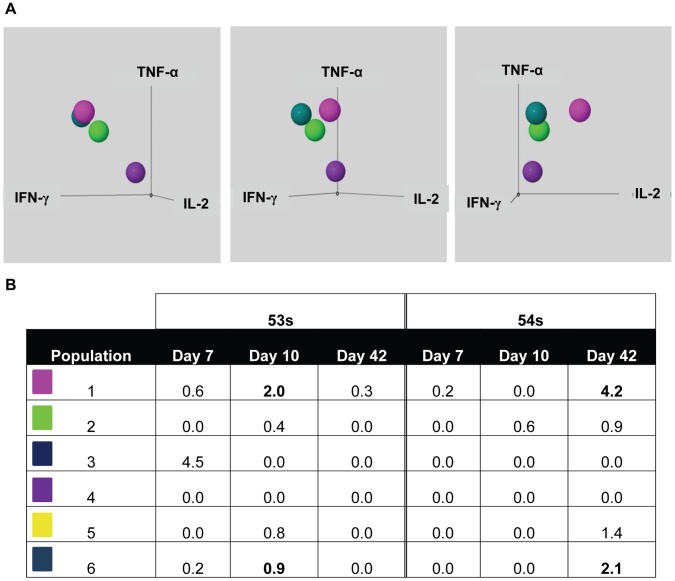
Three-dimensional representation of FLOCK data and percentages for each of the CD69+ populations at 3 time-points.A) Populations 1 (pink), 2 (lime green), 4 (purple), and 6 (aqua) shown in 3-dimensions. IL-2 is shown on the x-axis, IFN-γ on the y-axis, and TNF-α on the z-axis. B) Cross-sample analysis results showing net (day 0 subtracted) percentages of CD8+ TEM for each of the CD69+ populations at days 7, 10, and 42 post immunization for volunteers 53 s and 54 s. Peak responses for each population are bolded.